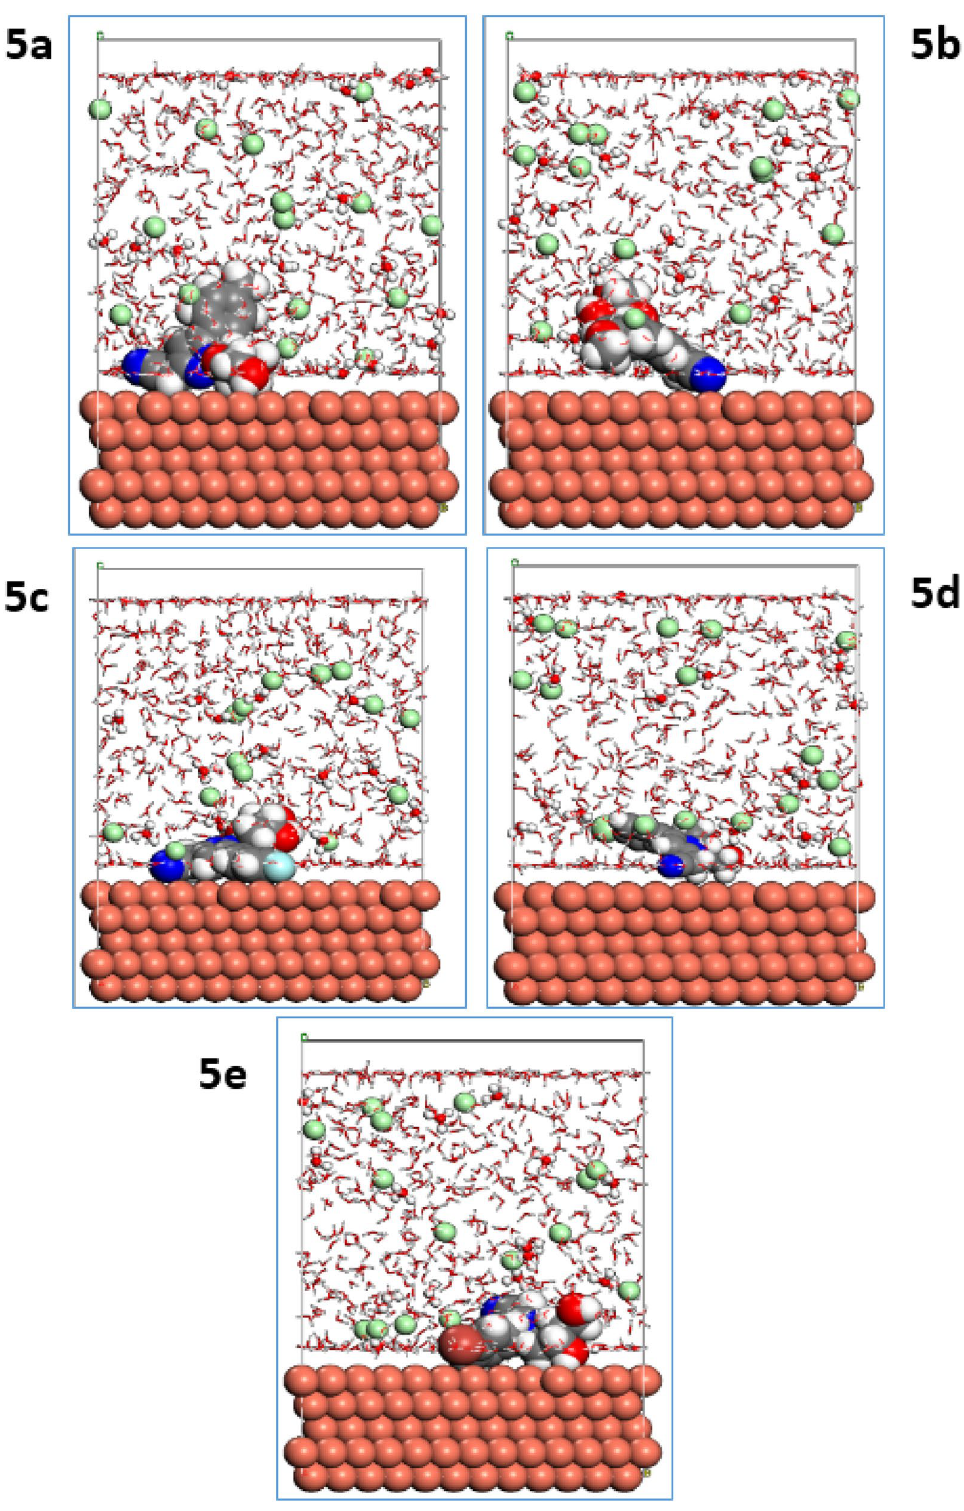
Figure 8. Side view of adsorption configurations of 5a – e on Cu(111) in aqueous